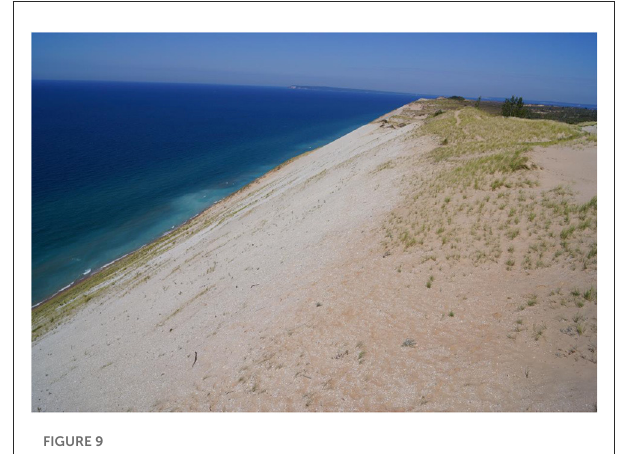
FIGURE6 Paper birch growing at pyramid point SLBE.